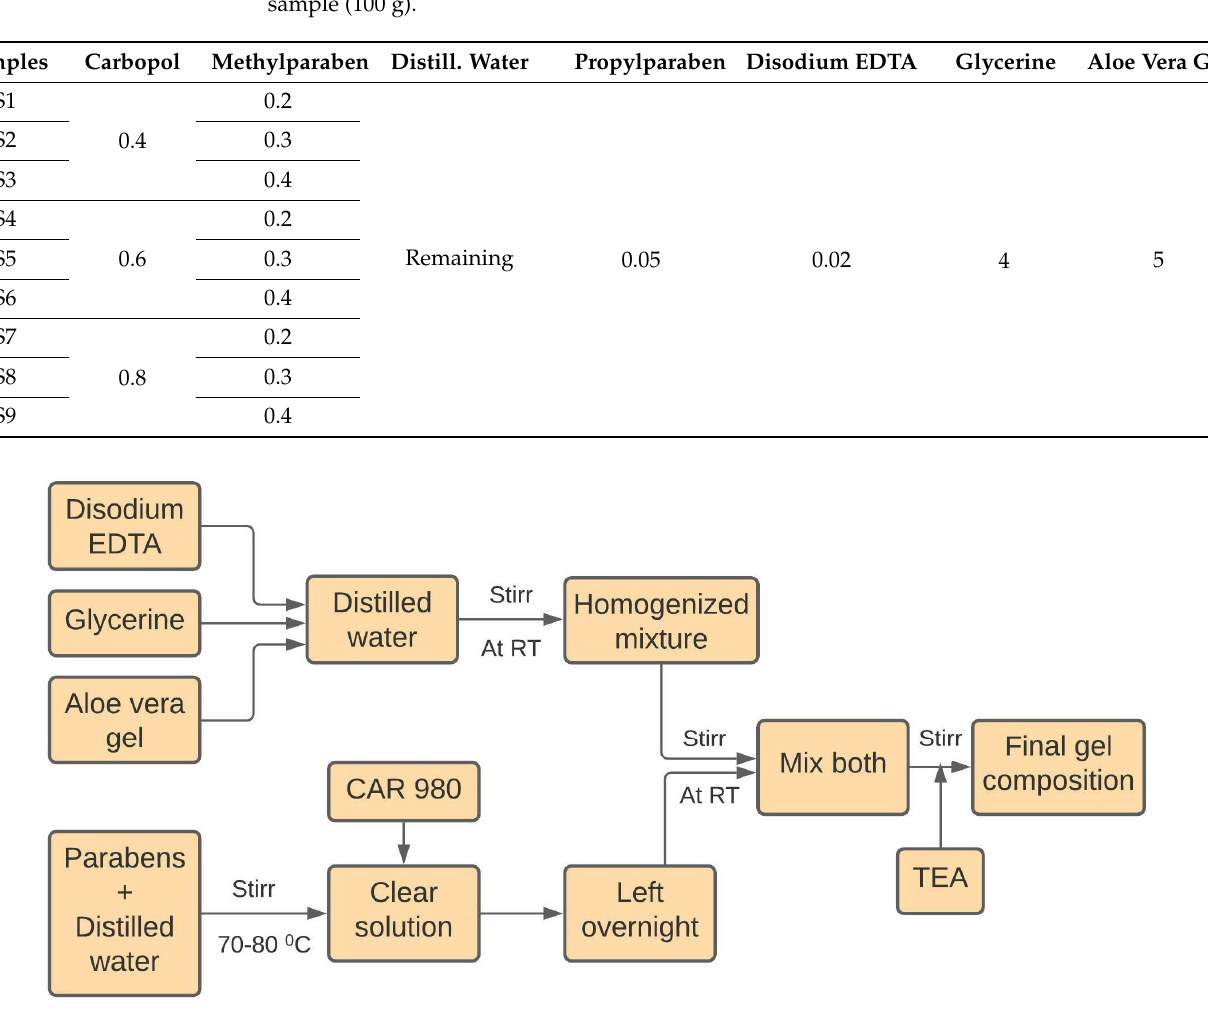
Figure 11. Flowchart for the synthesis of carbopol based ultrasound gel formulations.